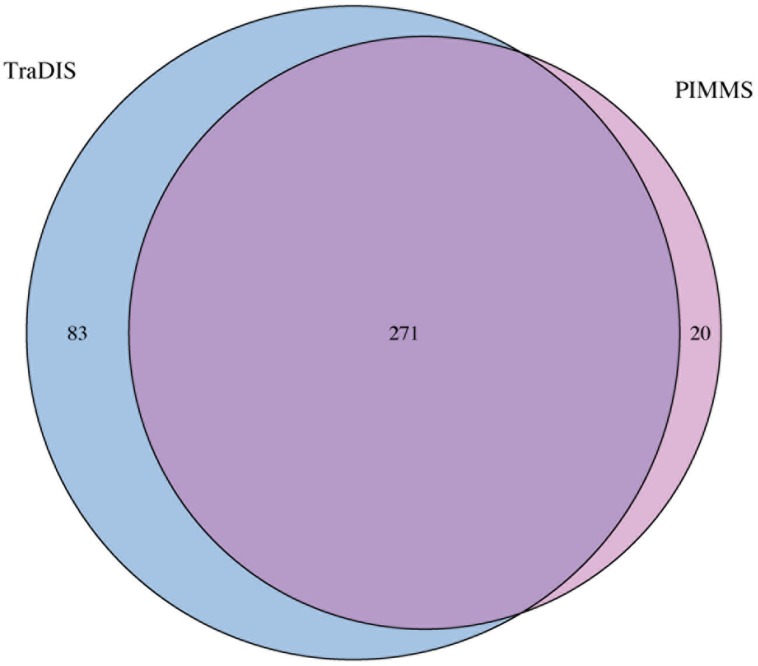
Overlap between identified essential genes detected by TraDIS (see Langridge et al., 2009 for data) and PIMMS. Genes were classified as essential if log2-LR < -2 (TraDIS) or NIM < 2 (PIMMS).